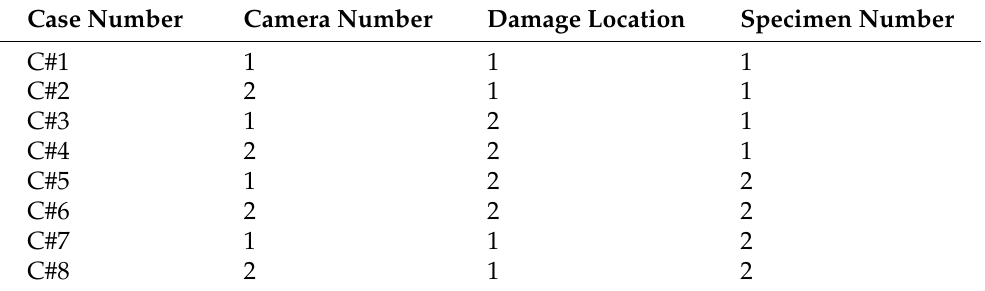
Figure 16. Flowchart of the AMS method. Table 3. Experiment